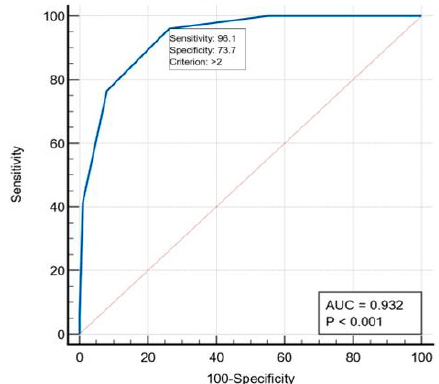
Figure 7. ROC curve—Mortality Score—Clinic County Emergency Hospital of Gala ț i/OCC.